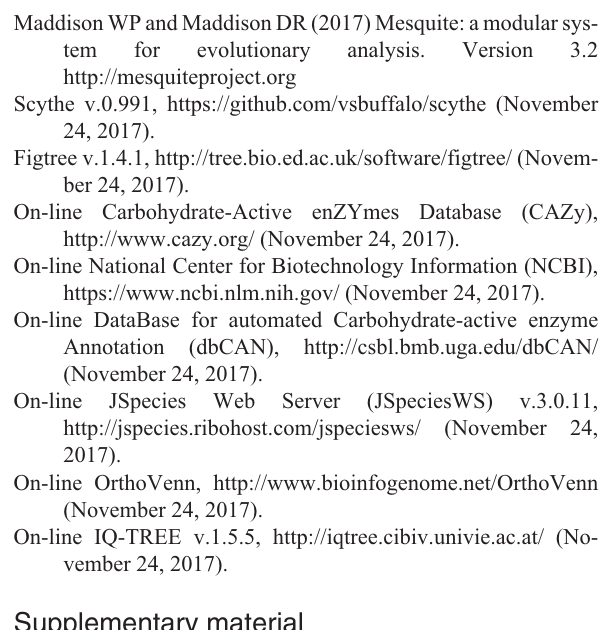
Table S1 - Scaffolds unspecific for Thermomonospora sp.